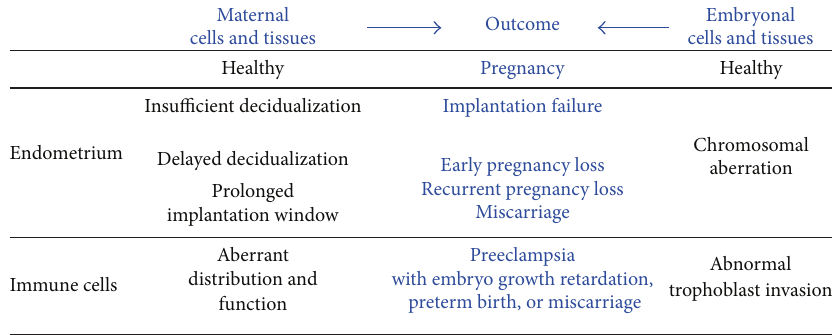
Figure 4: Pregnancy complications due to maternal and/or embryonic tissue functional